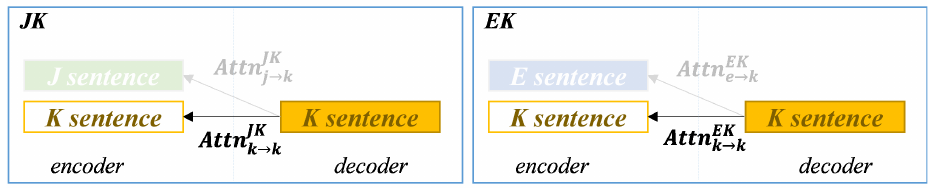
Figure 3. Comparison of cross-attentions between the same